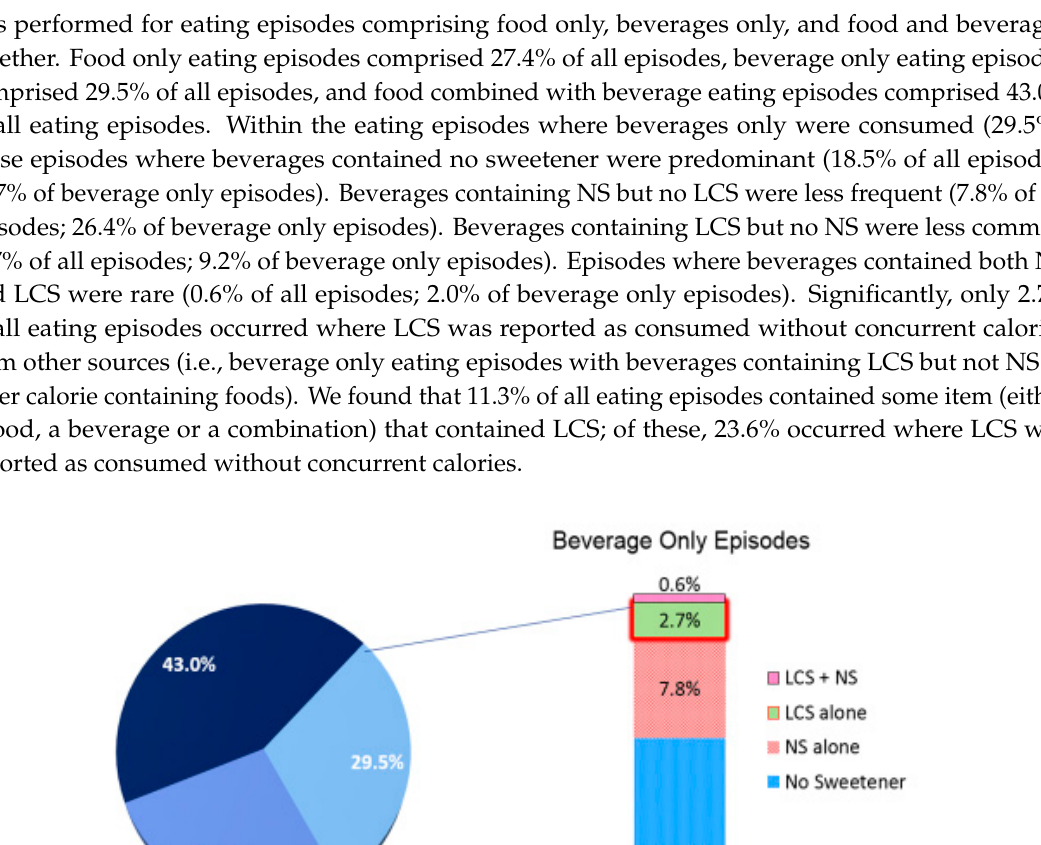
BMI categories: normal weight, overweight, and obese individuals (Table 1). In LCS non-consumers, in normal weight, overweight, and obese individuals, 38.8%, 38.4%, and 38.7% of eating episodes were free of sweeteners (i.e., either LCS or NS), respectively. In contrast, LCS consumers had a lower percentage of eating episodes without NS or LCS across all BMI categories (i.e., 30.4% in normal weight; 31.0% in overweight; and 30.5% in